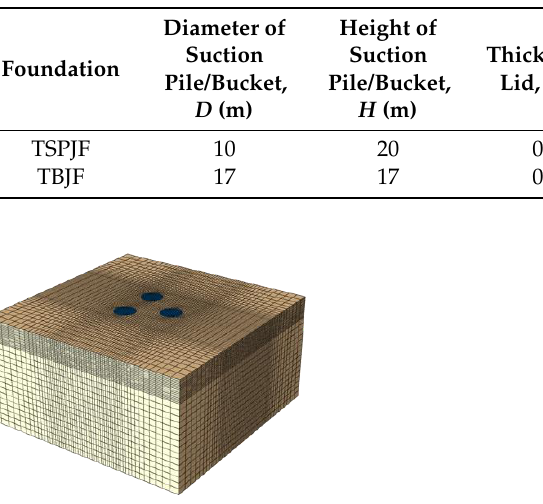
Table 1. Main parameters of the foundations.